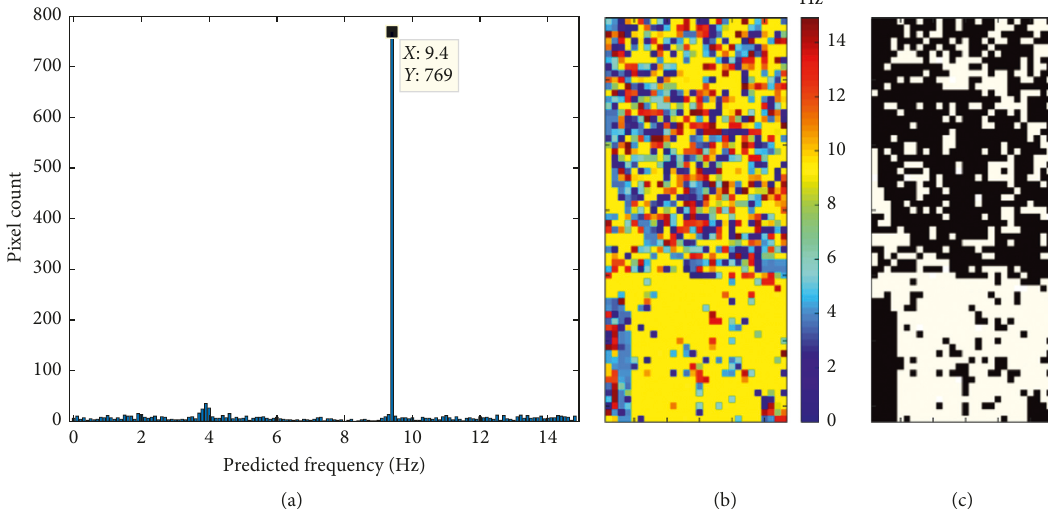
Figure 17: Cantilever steel beam experimental case 1 result from the proposed method. (a) Histogram of predicted frequency distribution. (b) Predicted outputs visualization in their original spatial position. (c) Highlighted pixels predicted as 9.4Hz for